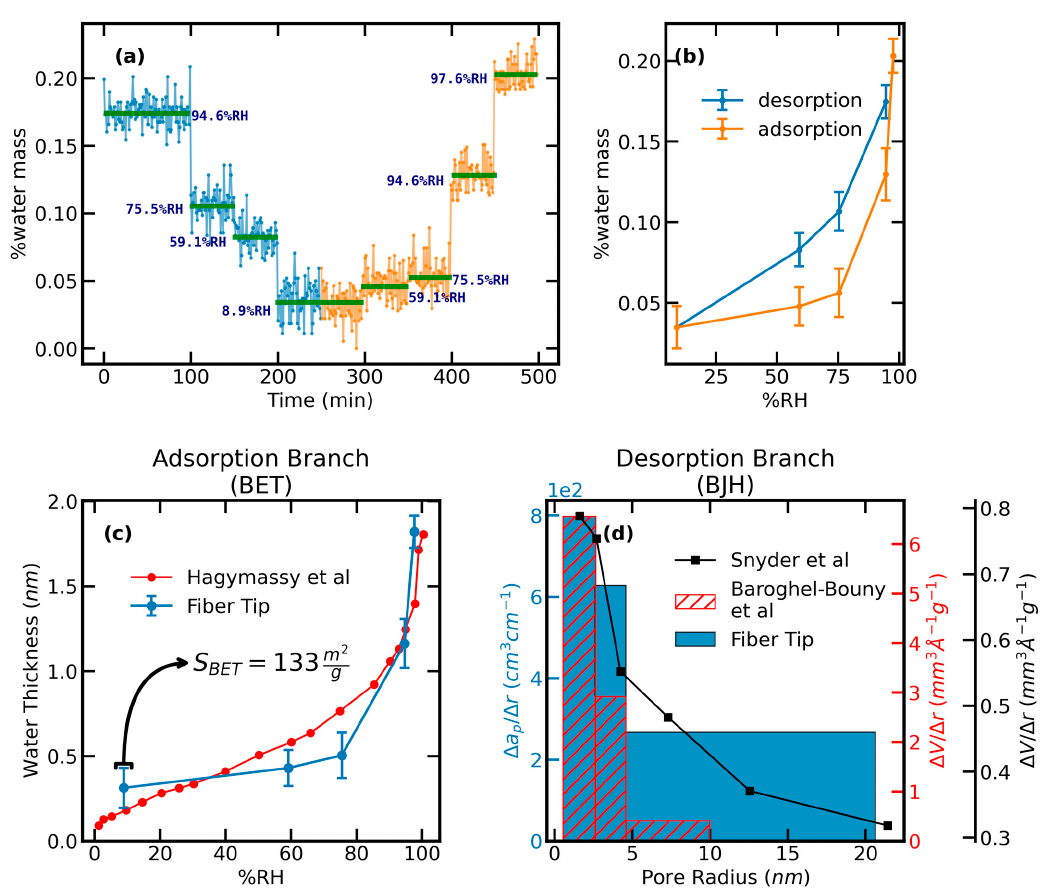
Figure 6. ( a ) % water mass from the normalized reflected light intensity for each of the saturated salt solutions used and the hysteretic behavior of the cement paste ( b ). ( c ) Estimated specific surface area and thickness of water retrieved from the adsorption branch of the cement paste water vapor hysteresis. Computed thickness of water ( nm ) is compared to the values found in the literature [25]. ( d ) Pore size distribution calculated from the desorption branch of the normalized reflected light intensity compared to values found in the literature [10,27].